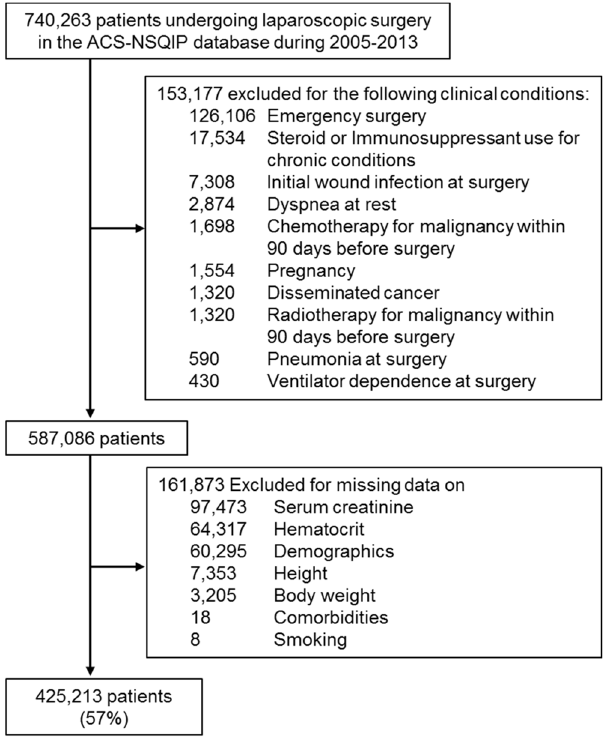
Figure 1. Study flow diagram. Abbreviations: ACS-NSQIP, American College of Surgeons National Surgical Quality Improvement